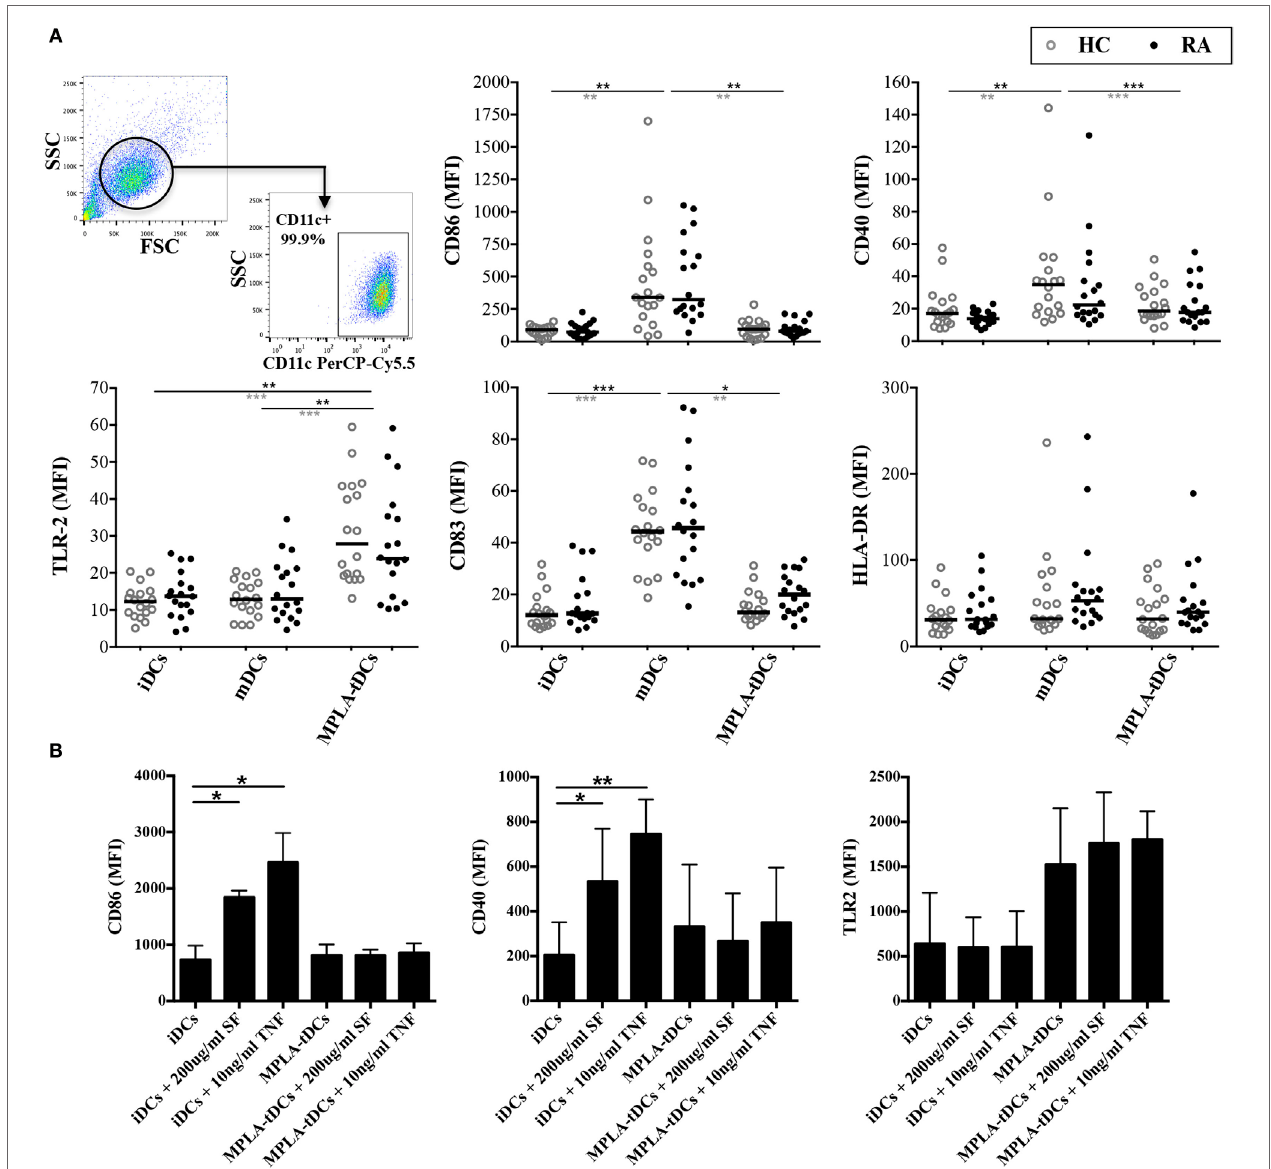
FigUre 1 | MPla-tDcs from rheumatoid arthritis patients and healthy controls display a tolerogenic phenotype that remains unaffected under pro-inflammatory conditions . (a) Monocytes from patients with rheumatoid arthritis (RA) ( black closed symbols ) and from healthy control (HC) subjects ( gray open symbols ) were differentiated into DCs in the presence of GM-CSF and IL-4 within 5 days. For tolerization, DCs were conditioned with dexamethasone (Dex) during 48 h and were additionally activated with MPLA for the last 24 h of culture (MPLA-tDCs). Surface expression levels of CD86, CD40, CD83, HLA-DR, and TLR2 were assessed by flow cytometry. Dot plots show all data points and median values are indicated as a line. (B) MPLA-tDCs from RA patients were incubated for 72 h in the presence of synovial fluid (200 μ g/ml) or TNF α (10 ng/ml), and the expression of phenotypic markers was analyzed. Untreated iDCs were used as controls. Statistical differences were calculated using either Kruskal–Wallis test (comparison between HC and RA) or Friedman test (comparison between culture conditions) and Dunn’s multiple comparison was used as post test (* P < 0.05; ** P < 0.01; *** P <